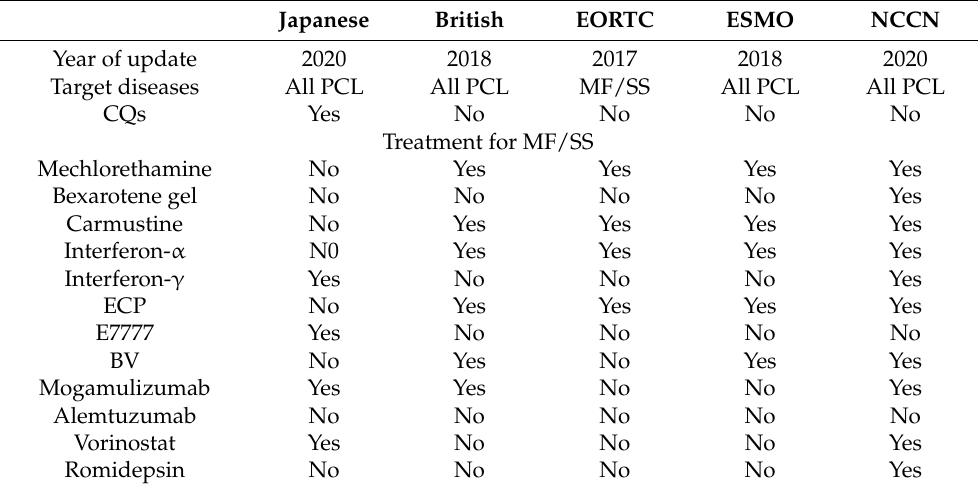
Table 1. The similarities and differences between the various sets of clinical